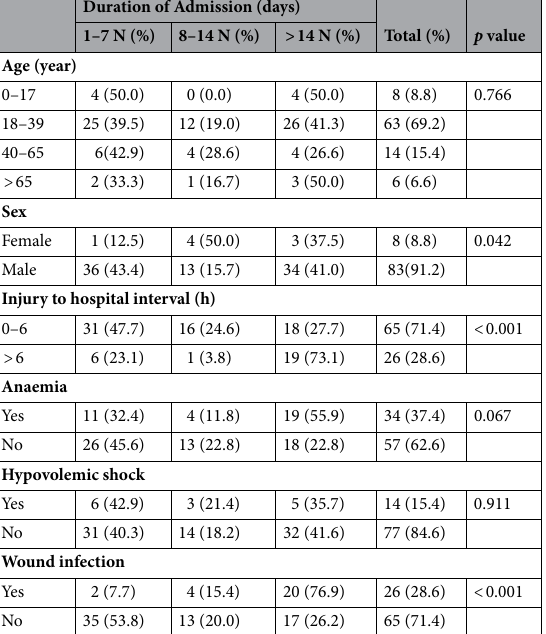
Table 5. Duration of hospital admission by demographics, intervention related factor and